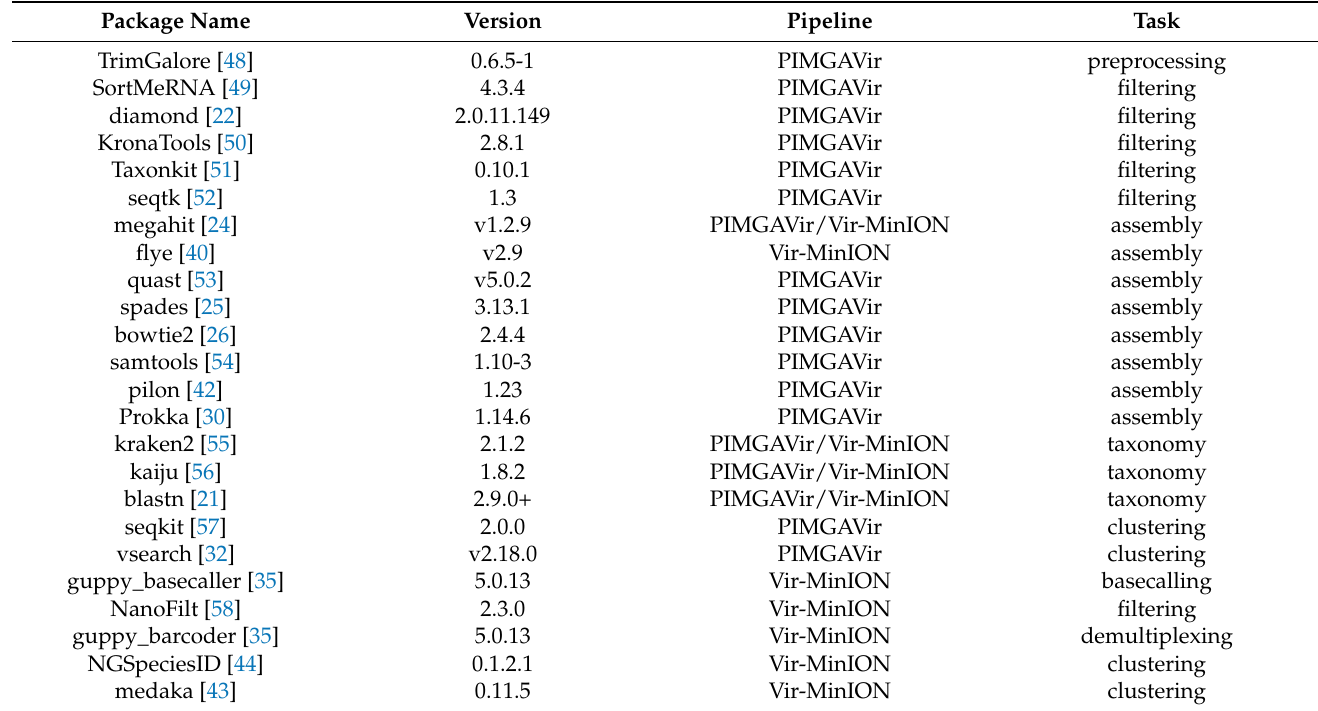
Table 1. List of used packages from PIMGAVir and